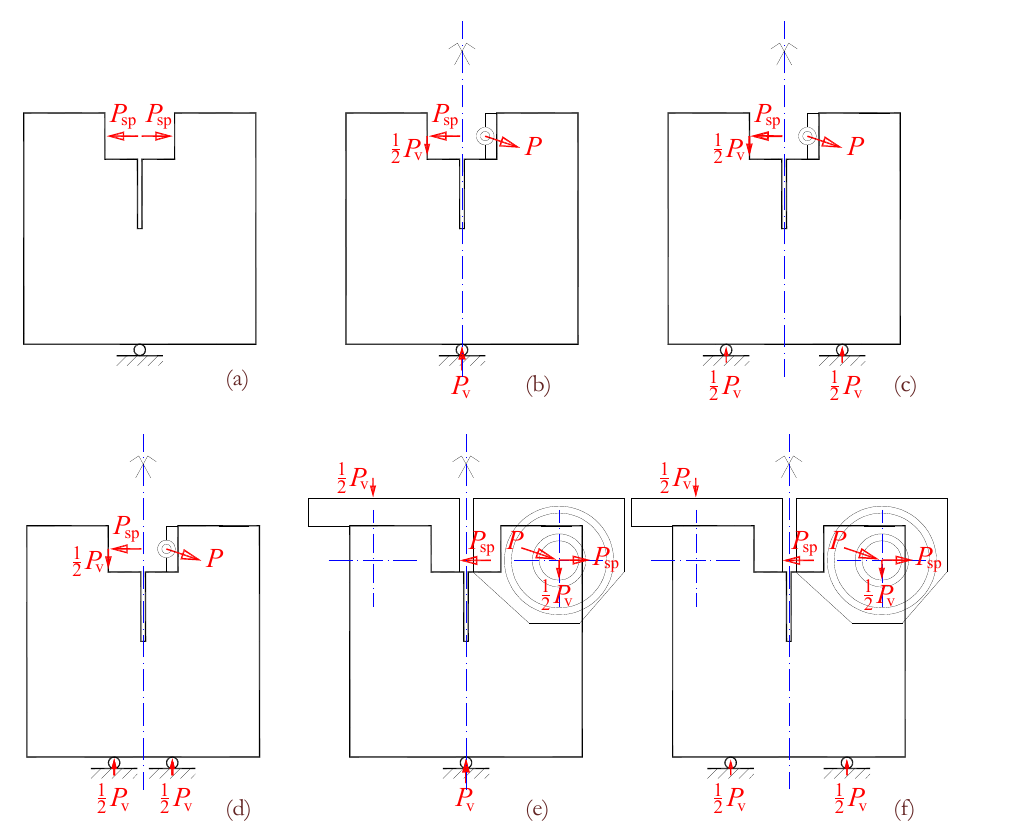
Figure 2: Schemes of variants of boundary conditions of the WST geometry in both the area of the load application (differences between (a) vs. (b), (c) and (d) vs. (e) and (f)) and supports (differences between (a) vs. (b) and (e) vs. (d) vs. (c) and (f)). Taking into account the vertical component of the loading force is essential.